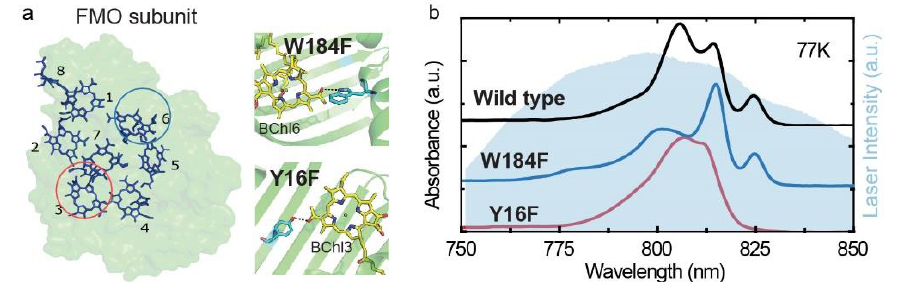
Fig. 1. (a) Crystal structure of the FMO subunit and highlights the perturbed BChls in the mutants. (b) Absorption spectra for the FMO and the two mutant complexes at